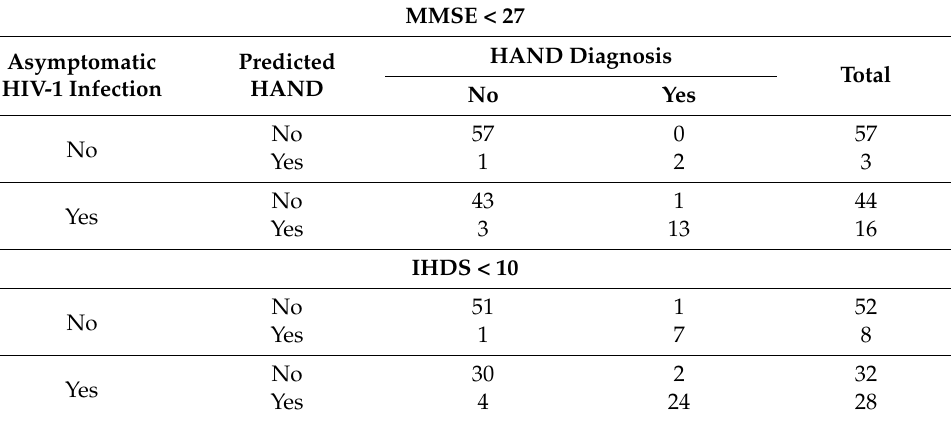
Table 6. Number of individuals with HAND and ARPA-based predicted HAND diagnosis by HIV- 1 infection status using the derived community-specific cut-off values for the MMSE and IHDS. HAND diagnosis was defined according to the community-specific cutoff values. Age, sex, years of education, and the neuropsychological tasks comprising our short screening protocol were used as predictors in the ARPA-based